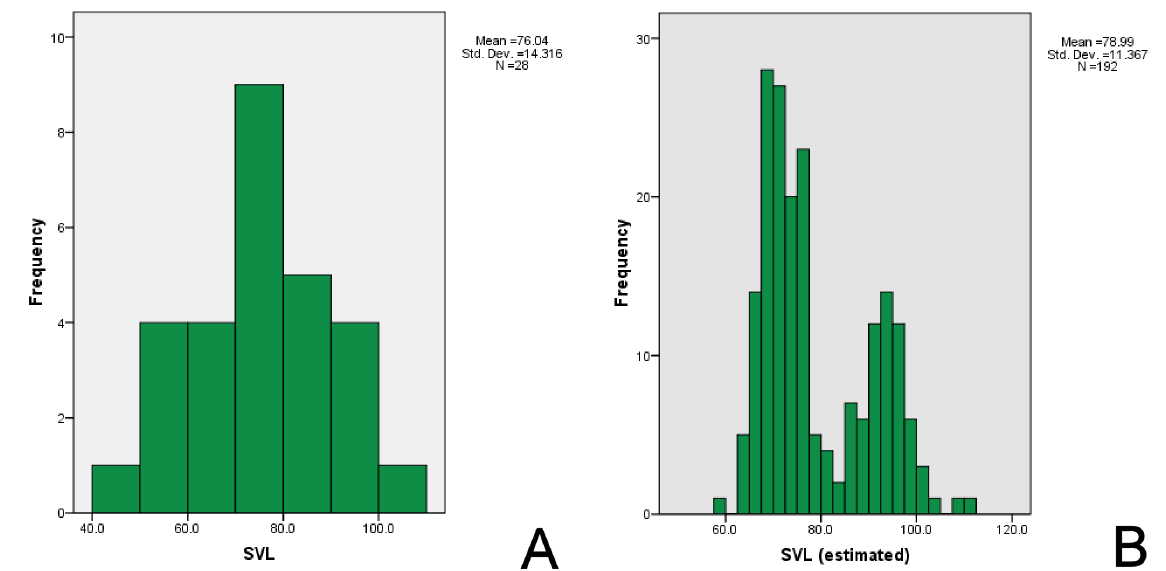
Fig. 3. Histograms. A . Snout vent length (in mm) in adult Fejervarya cancrivora (Gravenhorst, 1829) from samples collected for scientific purposes (Boulenger 1920) and collection specimens as mentioned in Material and methods. B . Snout vent length estimated from tibia length of genetically identified frog legs from French supermarkets (specimen list, see